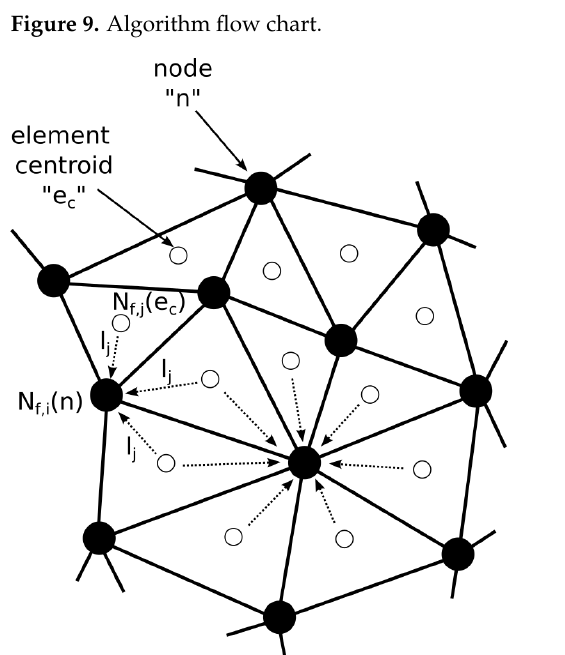
Figure 9. Algorithm flow chart.